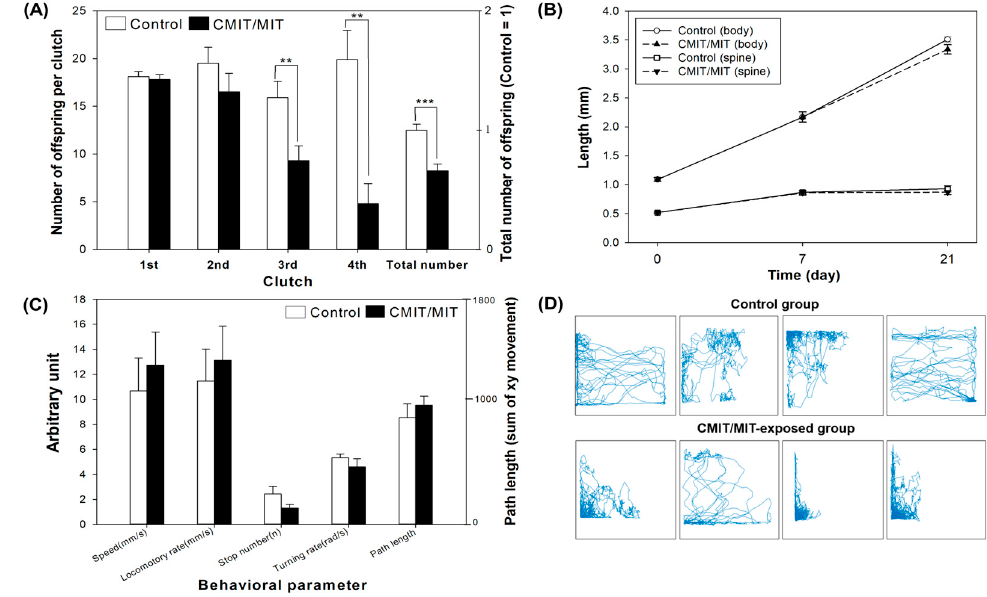
Figure 3. Reproductive capacity, growth, and swimming behavior of D. magna after exposure to EC20 CMIT/MIT (7 µ g/L): ( A ) Number of offspring per clutch and total number of offspring produced by adult daphnids exposed to CMIT/MIT for 21 days. ( B ) Growth of daphnids was observed on days 0, 7, and 21 after exposure to CMIT/MIT. ( C ) The quantitative value of behavioral parameters (speed, locomotory rate, stop number, turning rate, and path length). ( D ) The representative pictures of two-dimensional pathway (four images were selected) in the control and exposure groups. Data are presented as means ± SE (n = 10), with the asterisks indicating significant differences between the exposure and control groups: ** p < 0.01 and *** p <